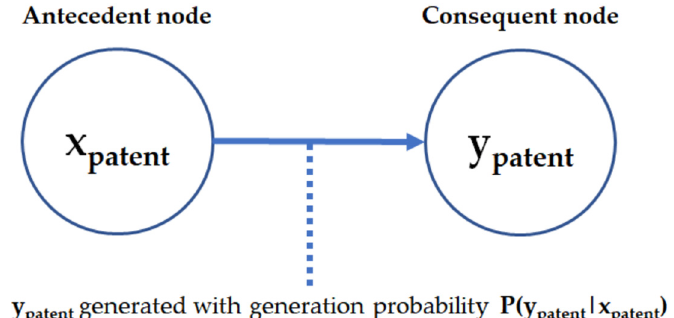
Figure 4. Sequential modeling of CART method to generate synthetic patent data.